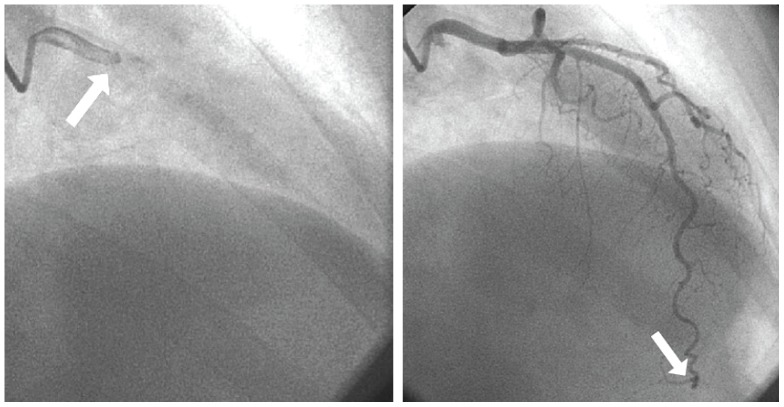
TIMI Frame Count.The first frame used to determine the TIMI Frame Count is the frame in which dye fully enters the artery of interest (left, arrow). The last frame that is counted is the frame when dye enters the distal landmark branch (right, arrow).